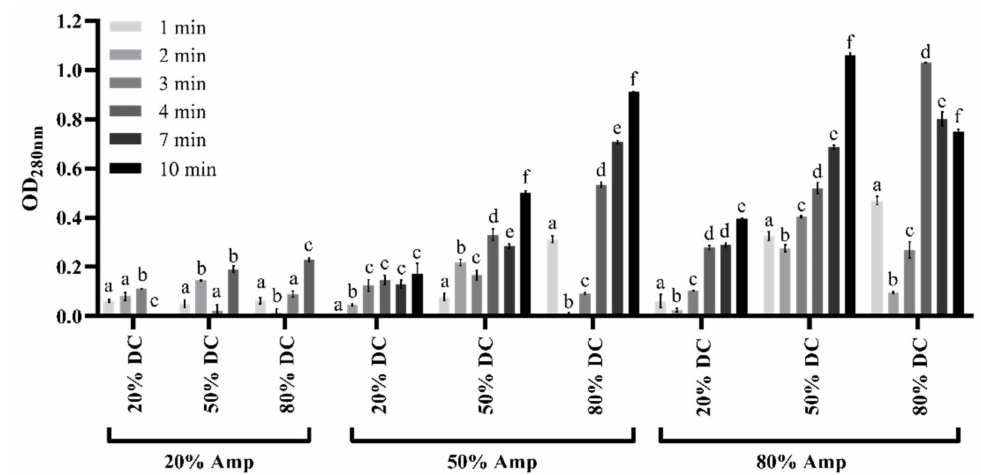
Figure 2. The optical density at 280 nm of supernatant samples collected after ultrasound treatment of SB62 cell suspensions. Sonication variables included percentage duty cycle (DC), percentage of the maximum amplitude (Amp) that was applied, and the total duration of ultrasound treatment in minutes. The data points for ultrasound durations of 7 and 10 min for 20% Amp are not shown in the figure due to technical problems with the sonication instrument associated with the cessation of sonication at this low intensity for prolonged periods of time. The data points shown are means for duplicate experiments and the error bars indicate standard deviation between replicates. Different letters indicate significant differences ( p < 0.05) between sonication durations within each separate treatment as analyzed by one-way ANOVA and the Fisher’s LSD test.